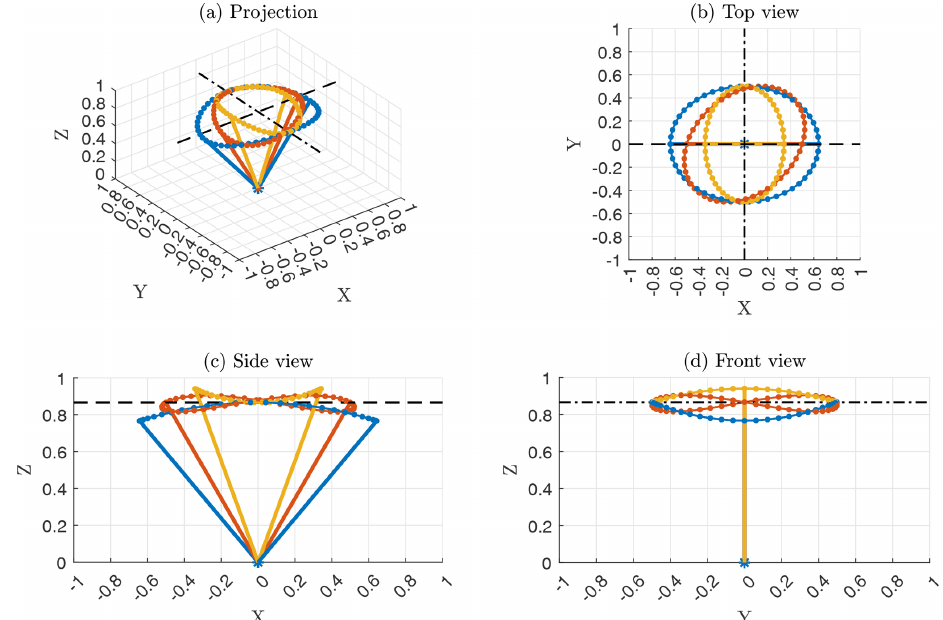
Figure 3. Measurement cone under the influence of pitch motion with oscillation frequency f p = f s = 1Hz and amplitude A = 10 ◦ . Colors represent different phase shifts between lidar prism angle and pitch motion. Only up- and downwind beams are depicted. The nominal measurement elevation is shown (black dashed